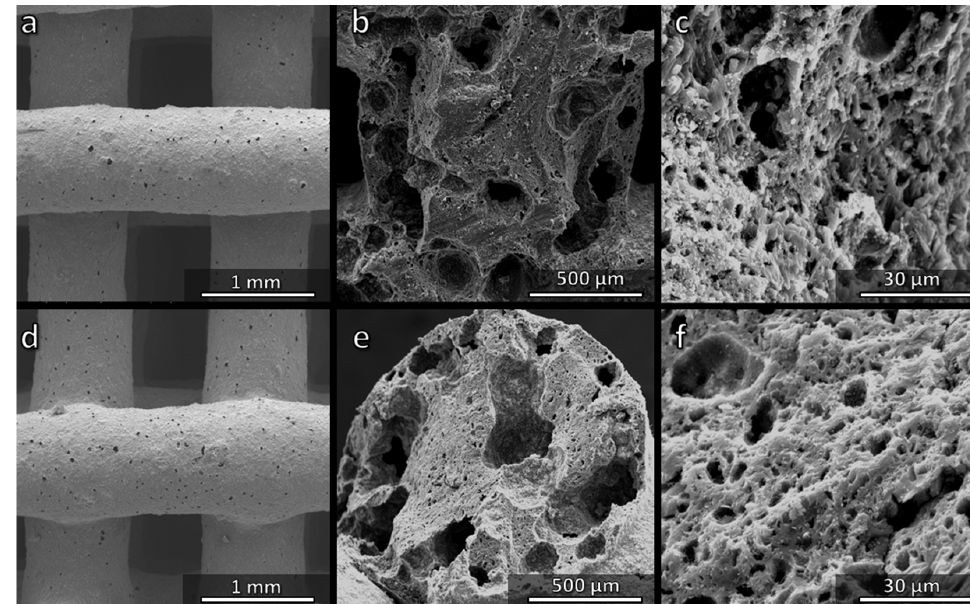
Figure 10. Comparison of the microstructure of Biosilicate ® -like/C scaffolds fired in N 2 prepared from H44-based inks comprising anhydrous sodium phosphate: ( a – c ) pre-heated at 60 °C; ( d – f ) pre- heated at 75 °C.